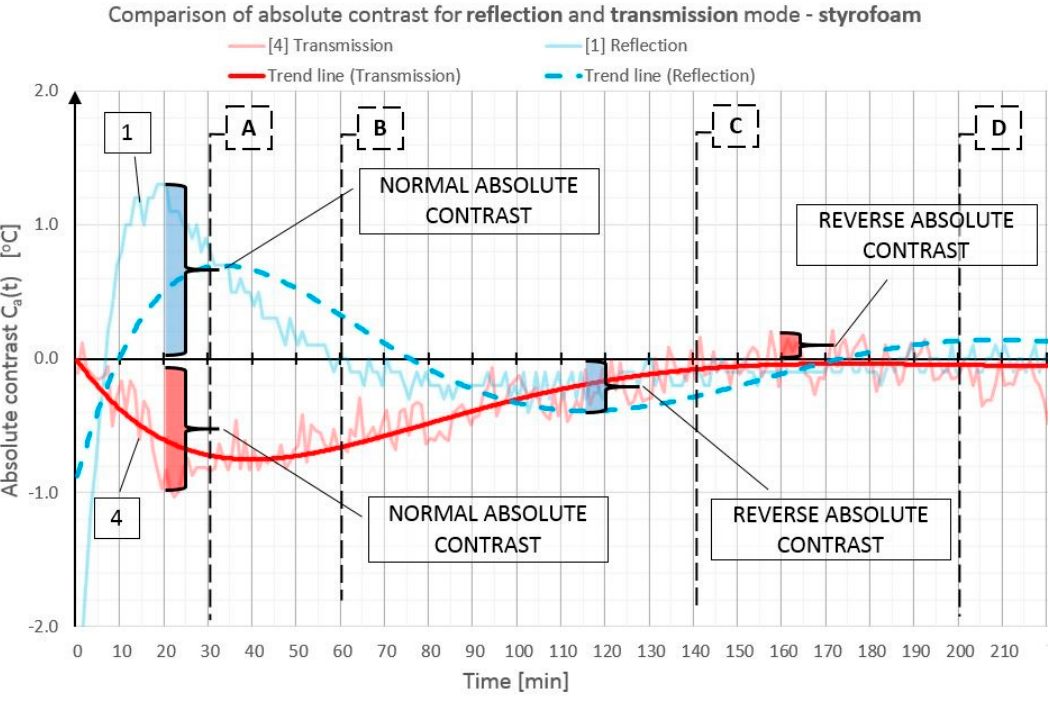
Figure 13. Diagram of absolute contrast in a reflection mode and in a transmission mode for Styrofoam inclusion, with marked places where normal absolute contrast and inverse absolute contrast occur (heating from a distance of 1.5 m).